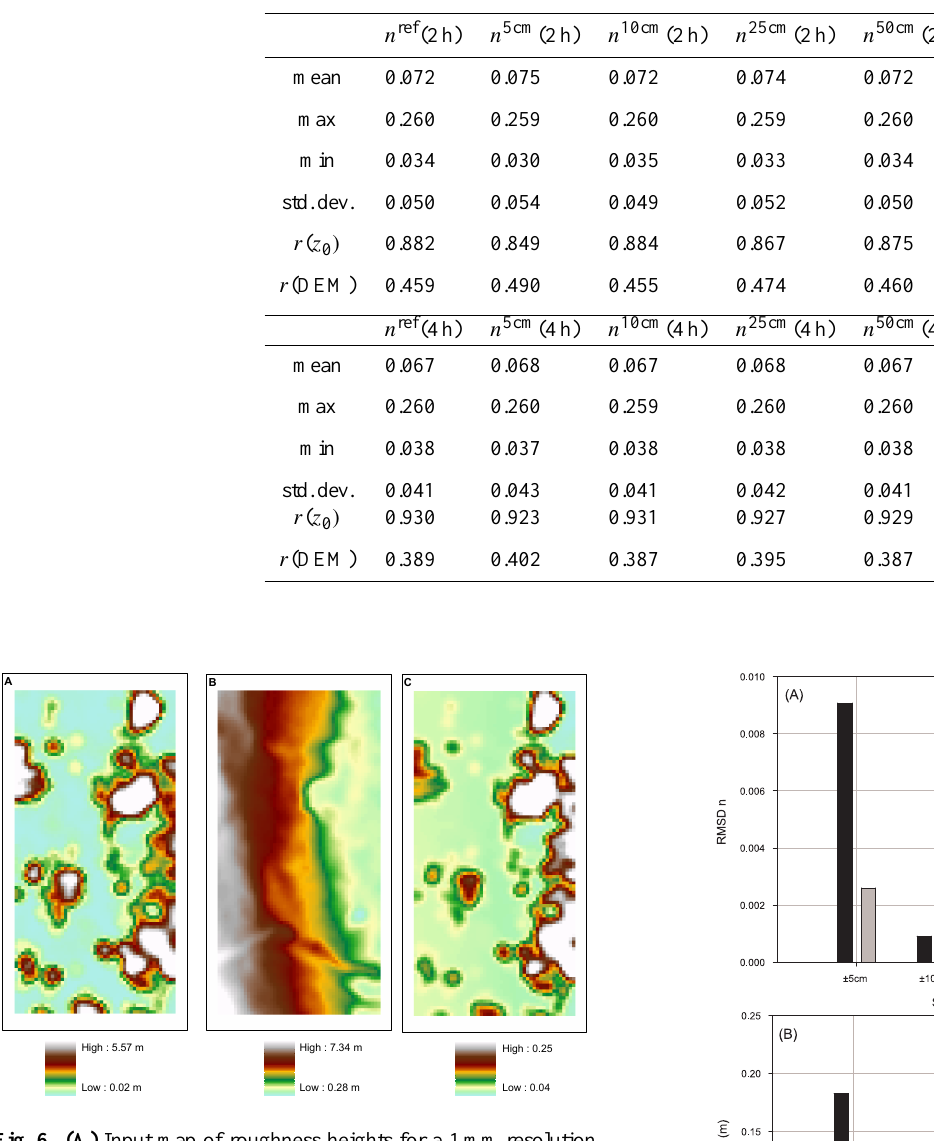
Fig. 6. (A) Input map of roughness heights for a 1mm resolution of detailed area. (B) Model estimated depths at the second hour. (C) Derived hydraulic roughness map calculated by the model at the second hour.